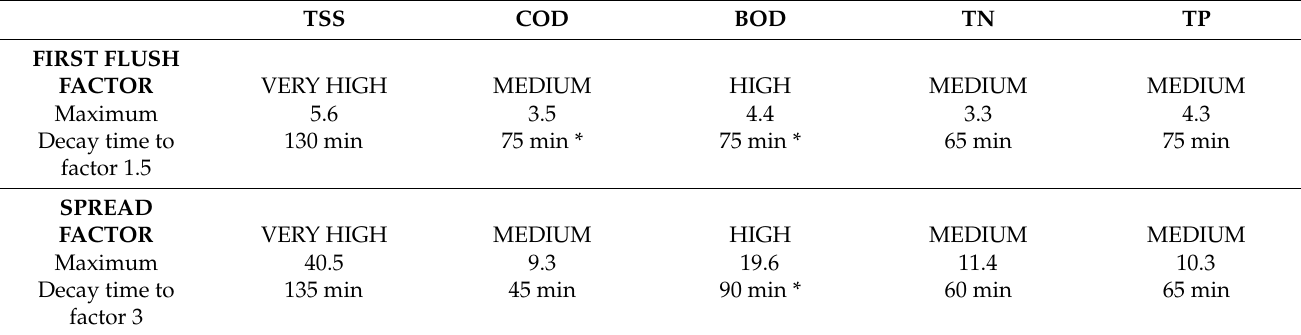
Table 3. Characteristics of first flush and spread factors for first 1.5 h of overflow event.